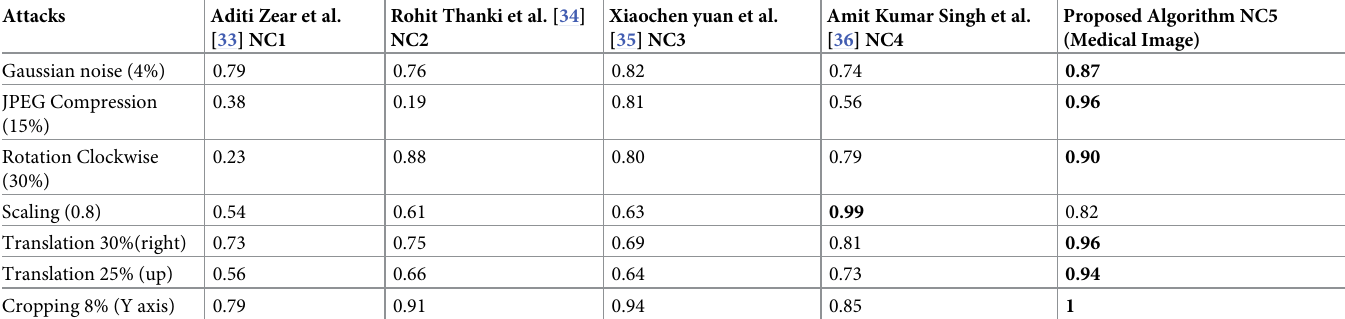
Table 5. Comparison of the proposed algorithm with other improved hybrid algorithms.